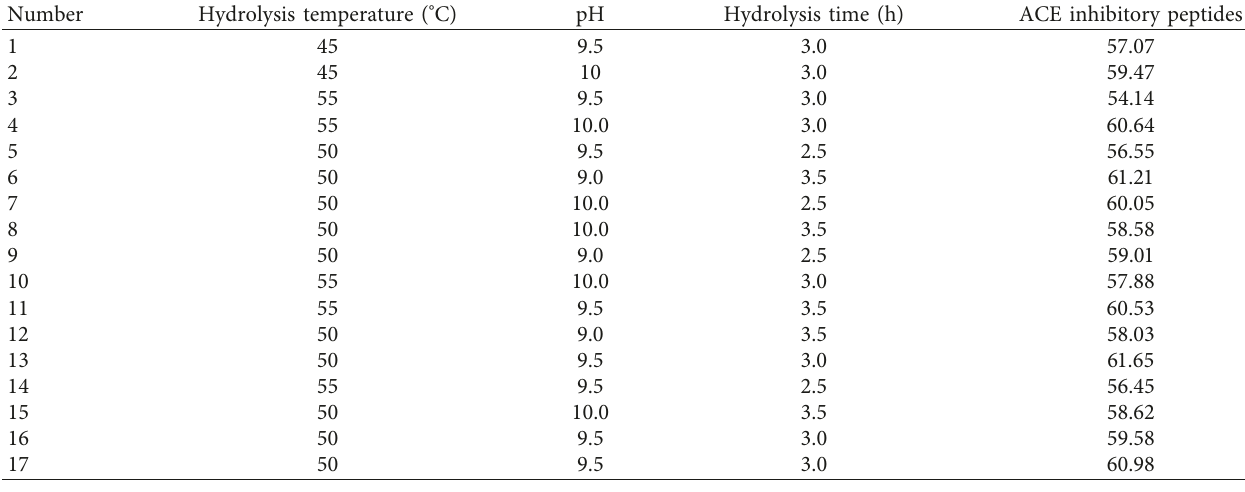
Table 1: Box–Behnken design and results for ACE inhibitory peptides by alkaline protease.